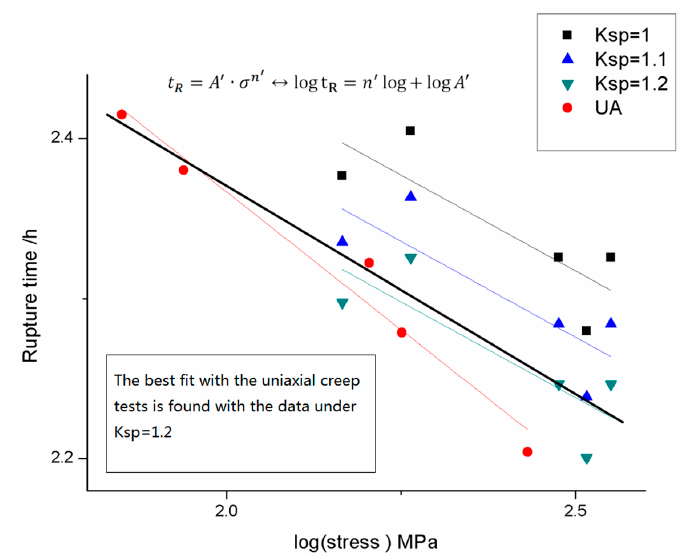
Figure 6. The rupture time versus stress fitting results of the small punch creep tests and the uniaxial tests of 16Mo3.